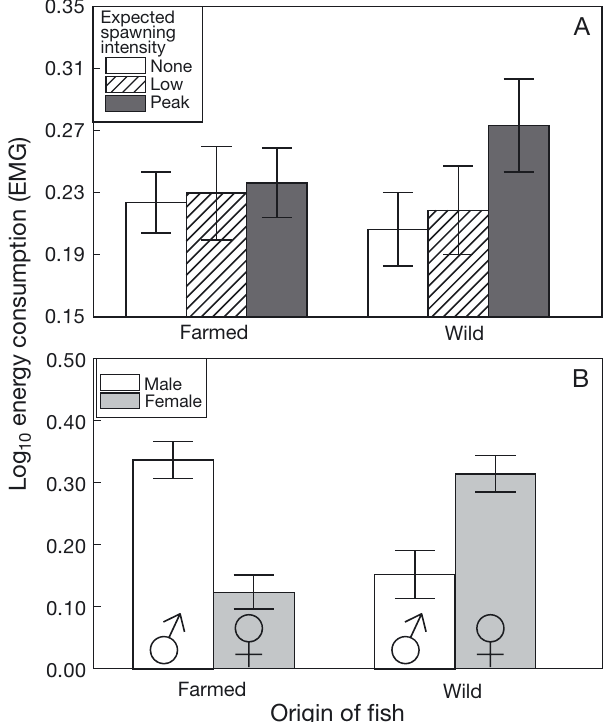
Fig. 5. Burbot energy consumption across (A) fish origins and spawning intensities and (B) fish origins and sexes. Values are adjusted means (±SE) from log 10 -transformed energy consumption data. EMG: